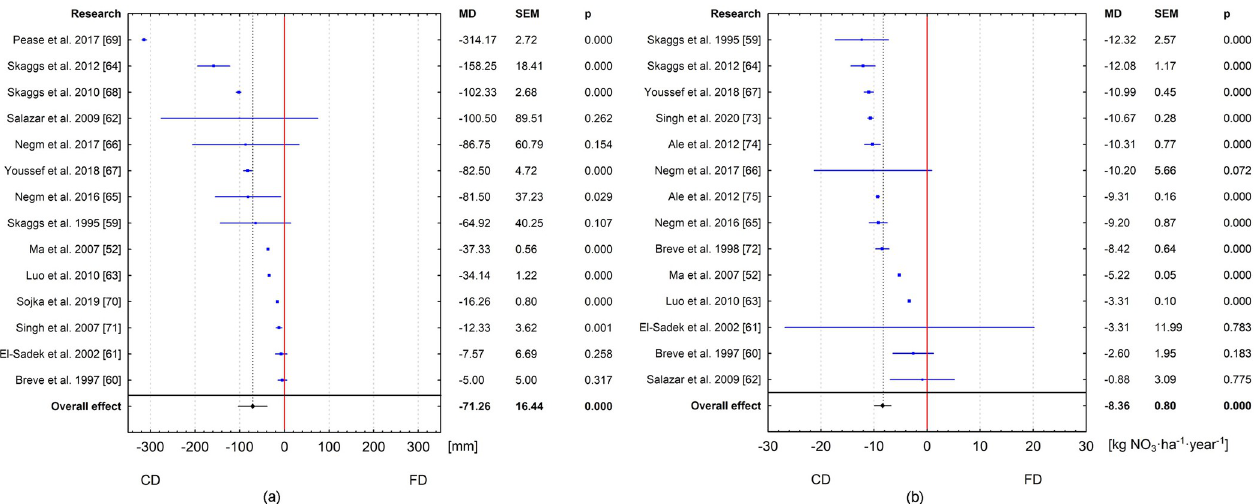
Fig 3. Meta-analysis for all articles: (a) subsurface drainage outflow reduction by CD versus FD; (b) reduction of nitrate load in drainage outflow by CD versus FD.